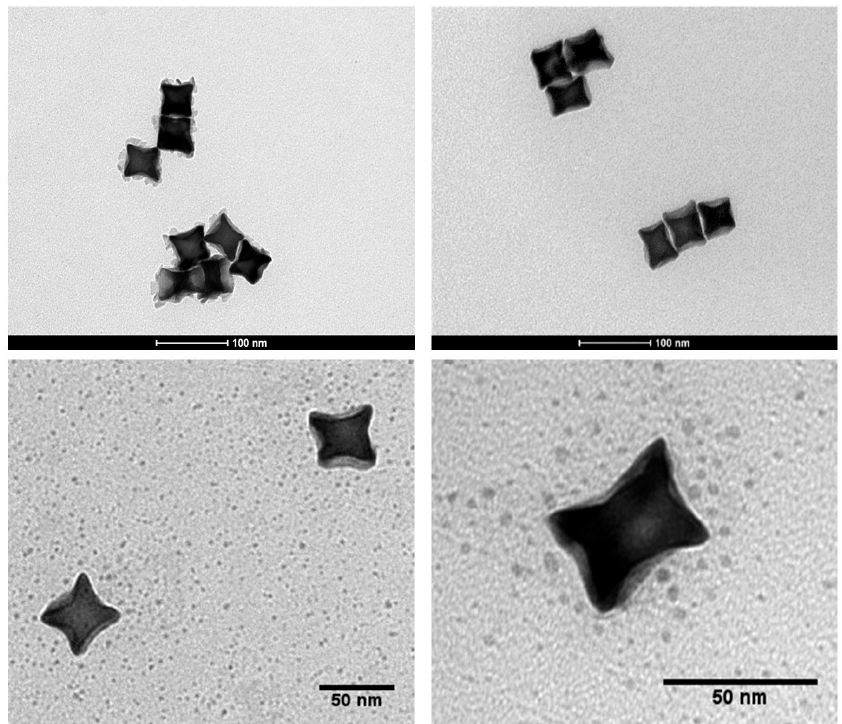
Figure 1. Transmission electron microscopy (TEM) images of concave cube gold nanoparticles.